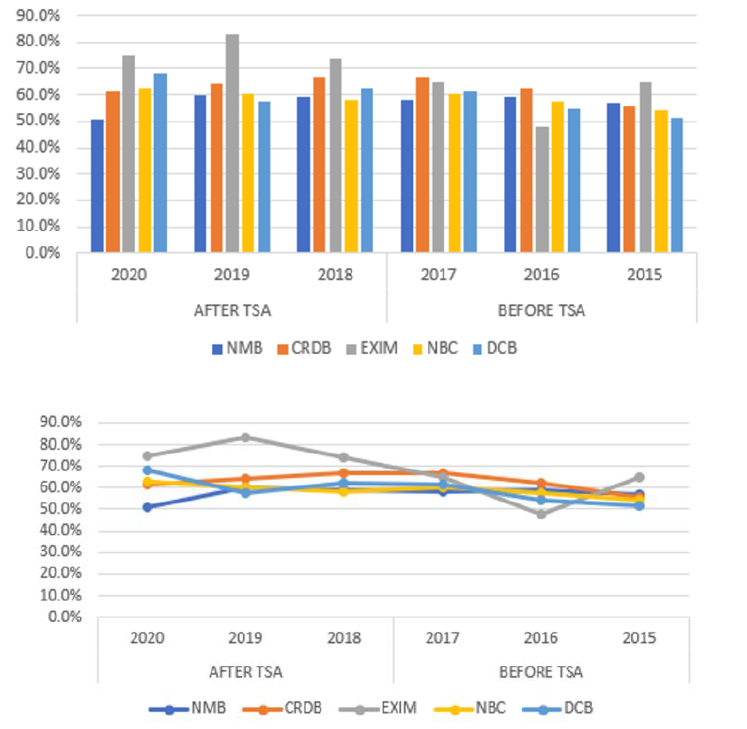
Figure 2: Management Efficiently Ratios; Source: Author’s Compilation, 2021